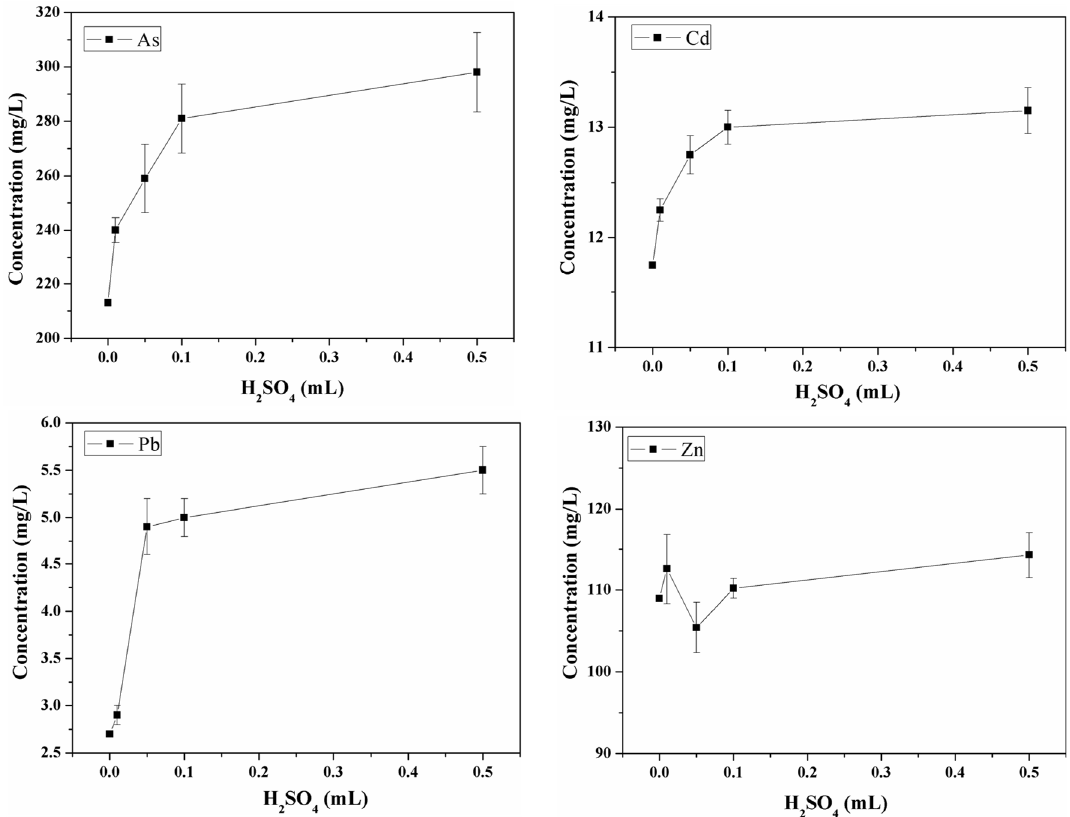
Figure 7. Effect of sulfuric acid addition on the release concentrations of heavy metals.